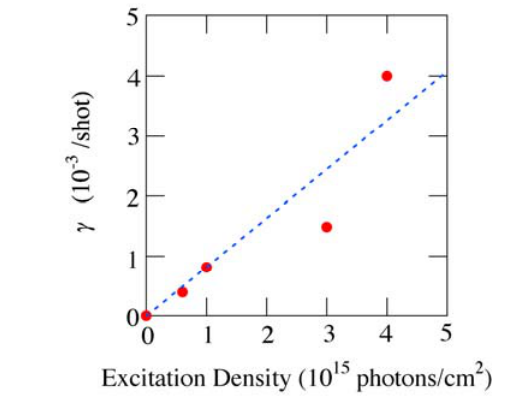
Figure 10. Photodegradation coefficient γ as a function of the irradiated excitation